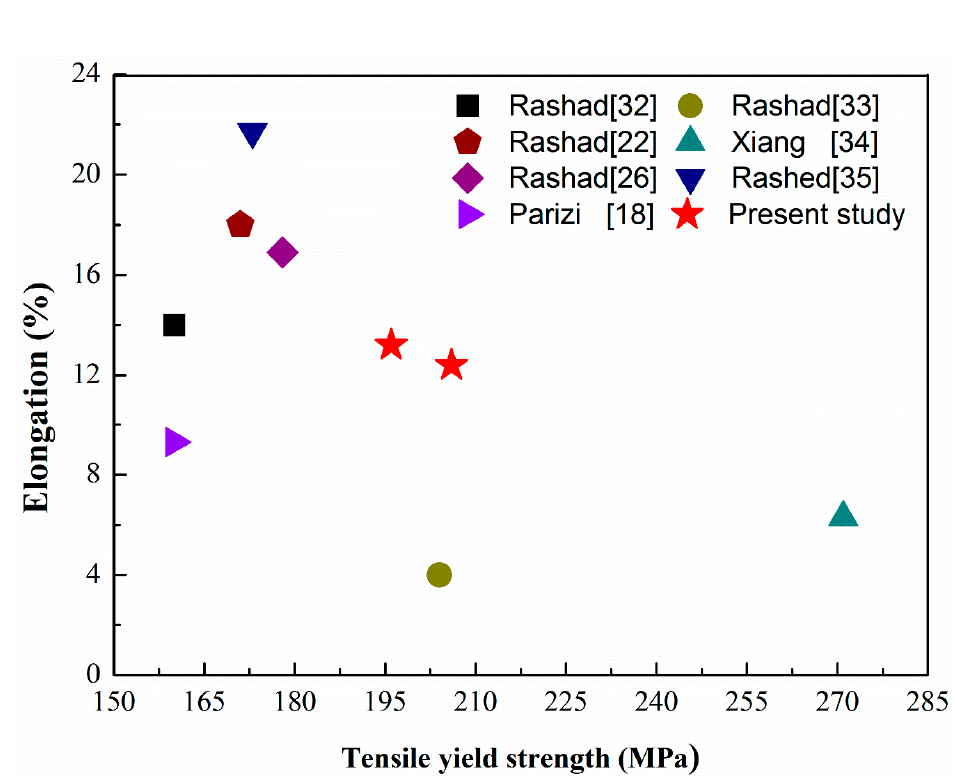
Figure 7. Comparison of tensile properties of the GNPs reinforced Mg alloy composites with previous studies.